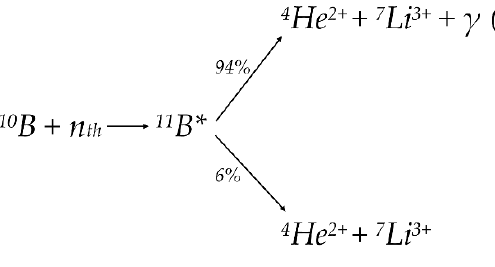
Figure 2. 10 B ( n , α ) 7 Li reaction.